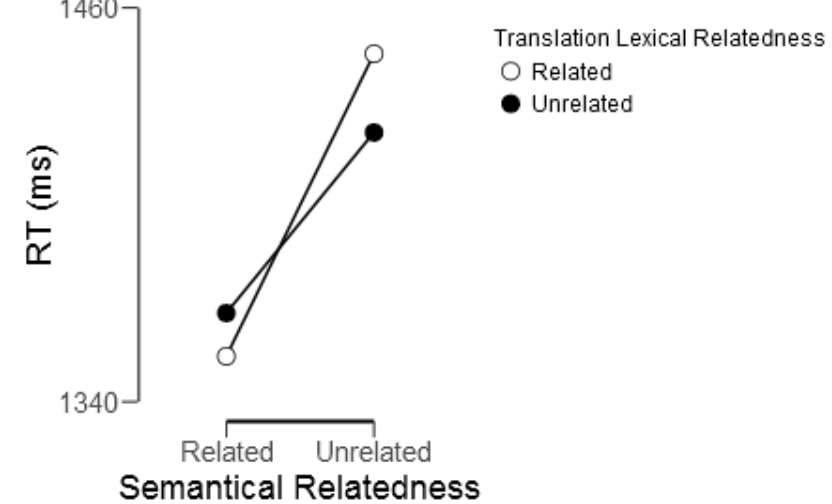
Figure 4. Reaction time (RT) interaction between semantic relatedness and L1 translation lexical relatedness.